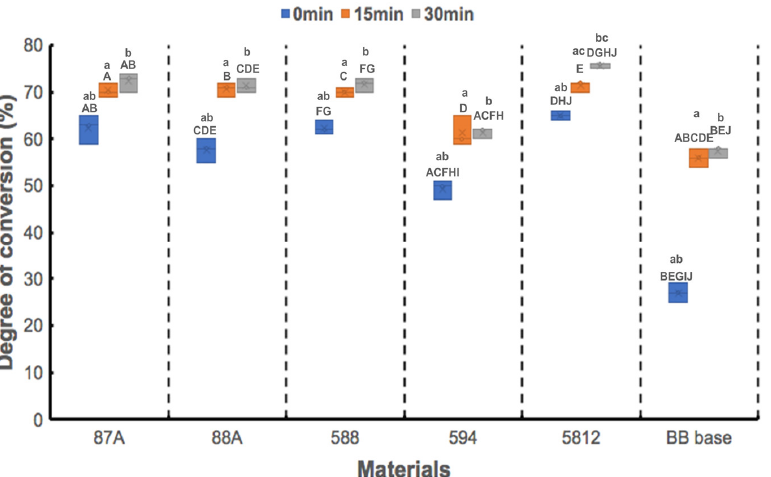
Figure 4. Degree of conversion for 5 UA-based photopolymer resins and a BB base. Same capital letter indicates static differences between materials for each UV-exposure period; same small letter indicates static difference between UV-exposure periods for each material.